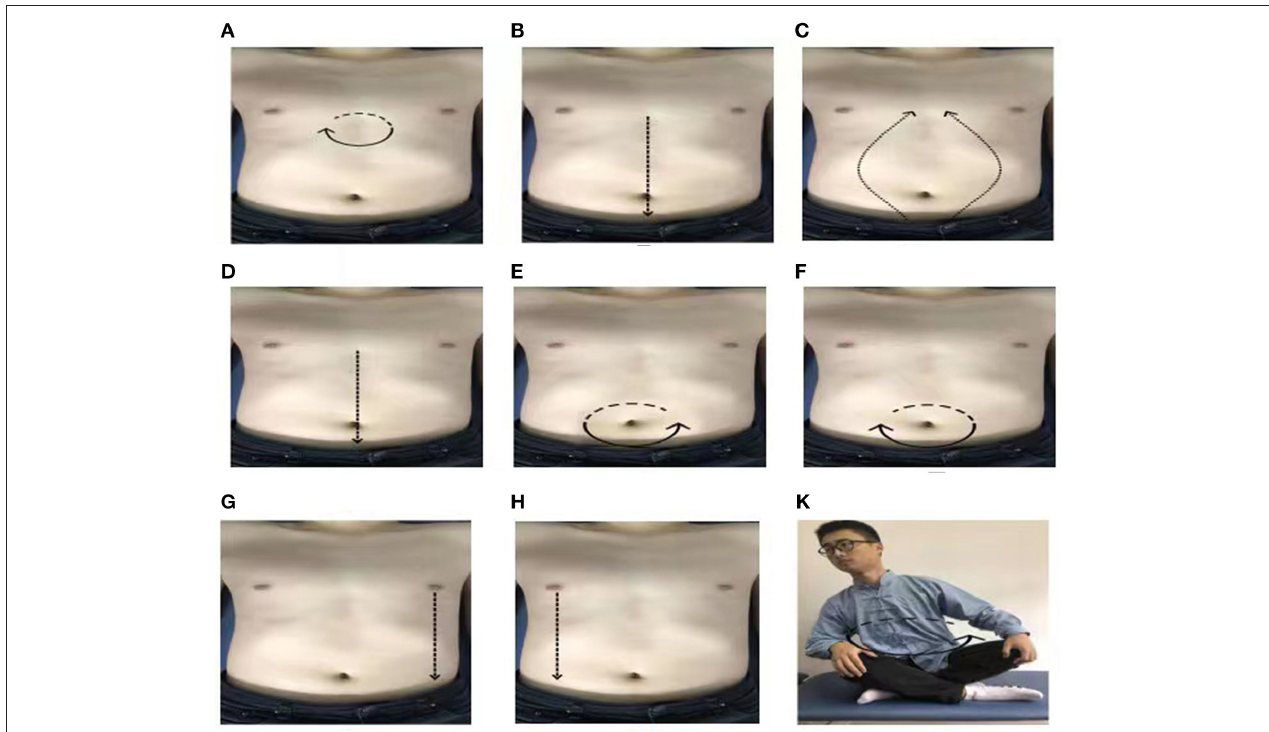
FIGURE 1 | The postures of PLWNT. (A) Press and knead acupoint in Danzhong. (B) Rubbing from Danzhong Acupoint to Pubic Symphysis. (C) Rubbing from Pubic Symphysis to Danzhong Acupoint. (D) Pushing from Danzhong Acupoint to Pubic Symphysis. (E) The right hand massages the abdomen by the left circle. (F) The left hand massages the abdomen by the right circle. (G) Pushing with the right hand from the left breast to the groin. (H) Pushing with the left hand from the right breast to the groin. (K) Turn left and right. Every movements will be carried out 21 times. PLWNT, prolong life with nine turn